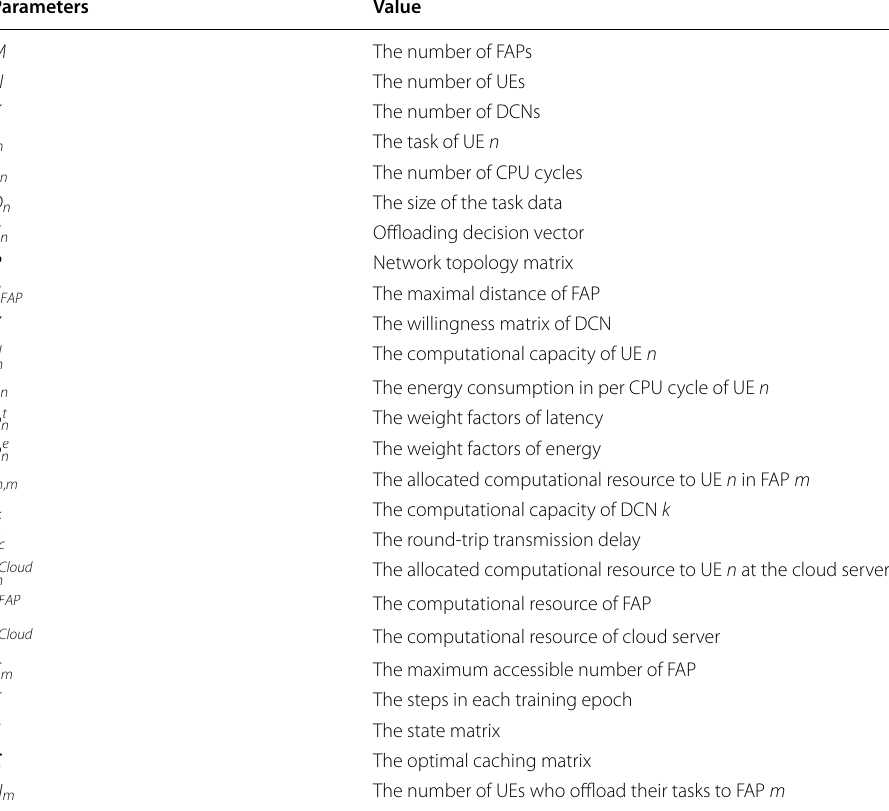
Table 1 Some important parameters Parameters